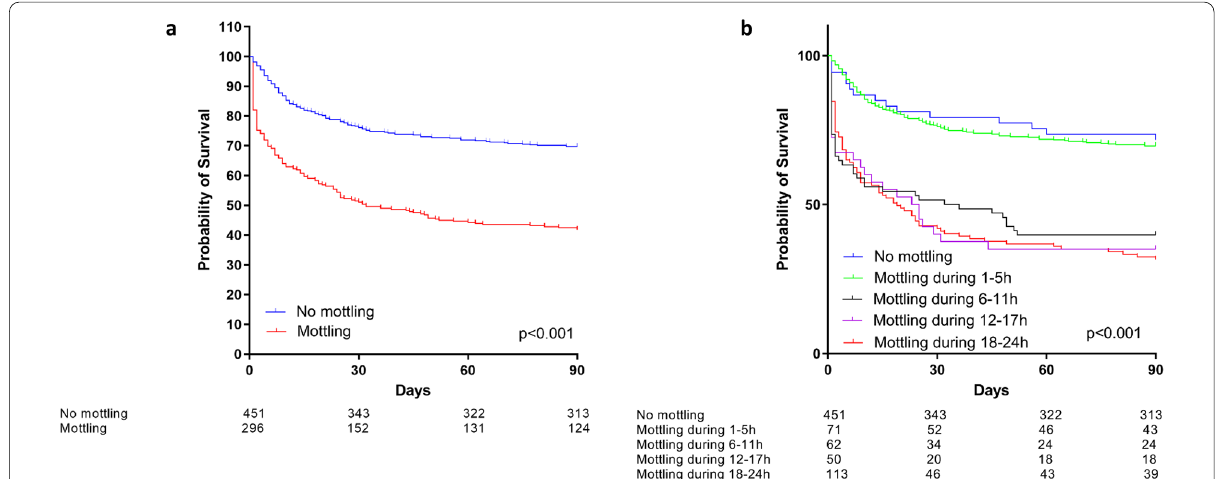
Fig. 4 Survival according to the presence (mottling) or absence of mottling (no mottling) during the first 24 h after inclusion ( a ) and according to the duration of mottling ( b ). a p ‑value refers to the difference between patients with mottling and those without. Log rank test: p < 0.0001. b p ‑value refers to the difference between each subgroup of mottling duration